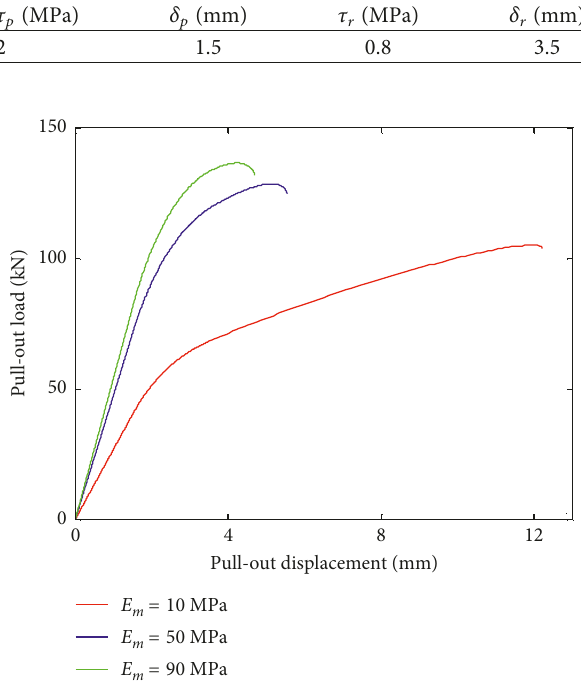
Figure 9: Influence of Young’s modulus of the confining medium on the performance of rock